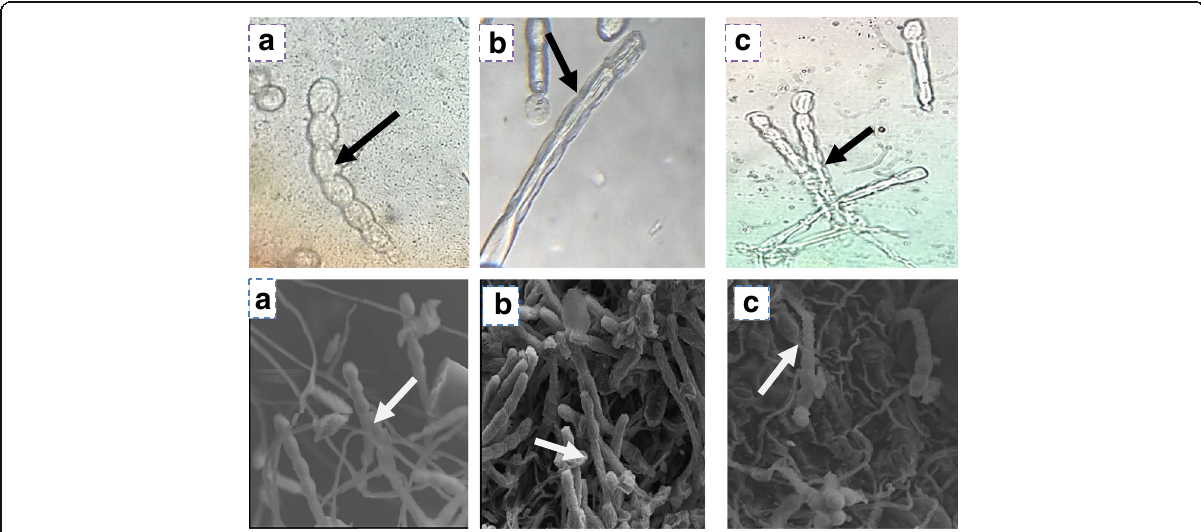
Fig. 2 Light microscopy and scanning electron microscopy (SEM) of P. xanthii on squash leaves . The growth characters of powdery mildew fungi in the control ( a ): leaves infected only with P. xanthii and after 24 h of treatment with B. subtilis ( b ) and T. harzianum ( c )